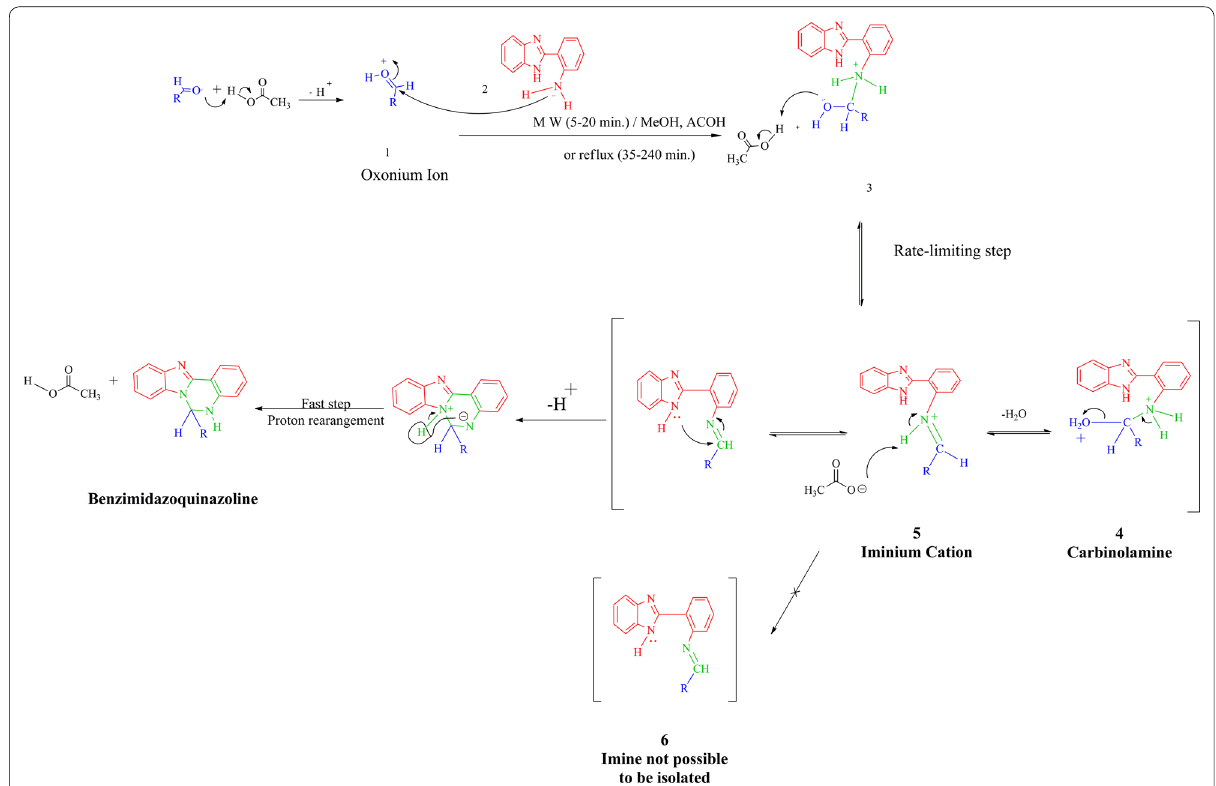
Fig. 7 Plausible mechanism for 6-heptyl-5,6-dihydrobenzo[4,5]imidazo[1,2- c ]quinazoline